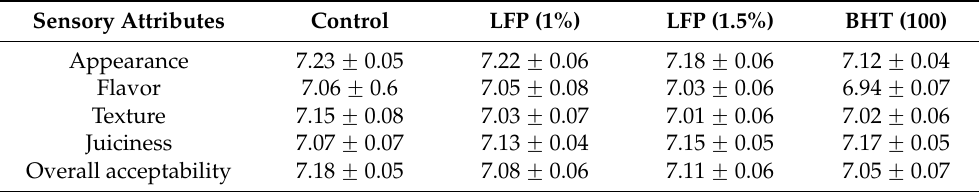
Table 3. Sensory attributes of sheep meat nuggets incorporated with litchi fruit pericarp extracts and